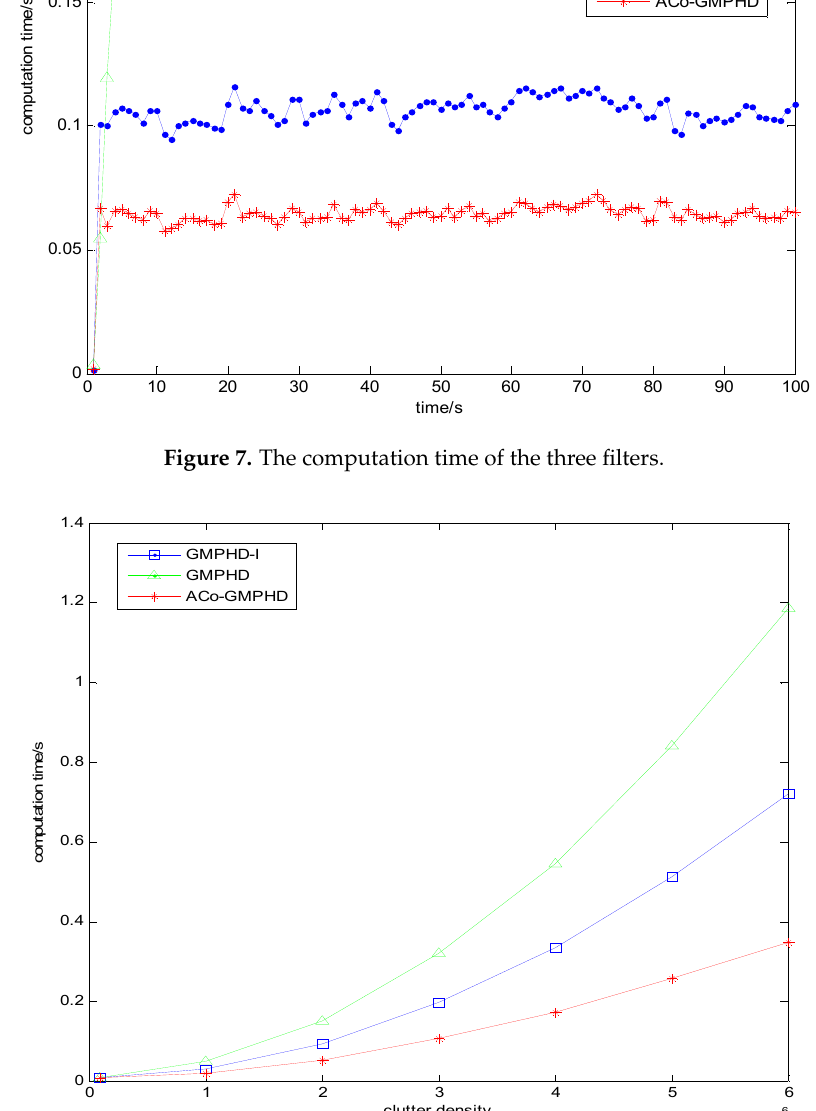
Figure 8. The time-averaged computation time under different clutter densities.